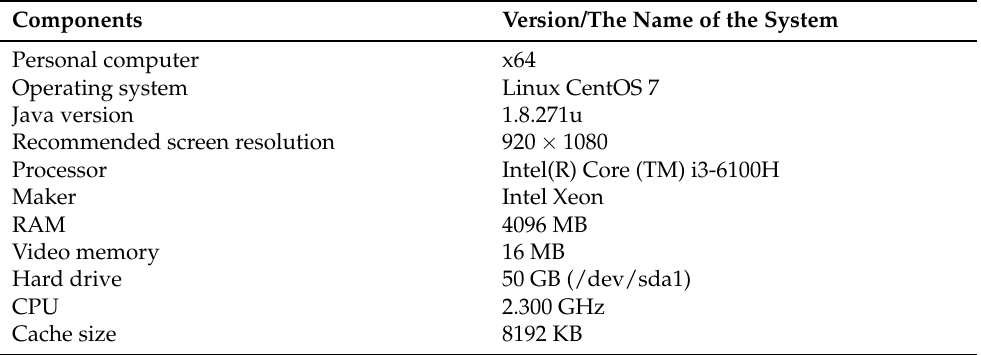
Table 1. Components of the web